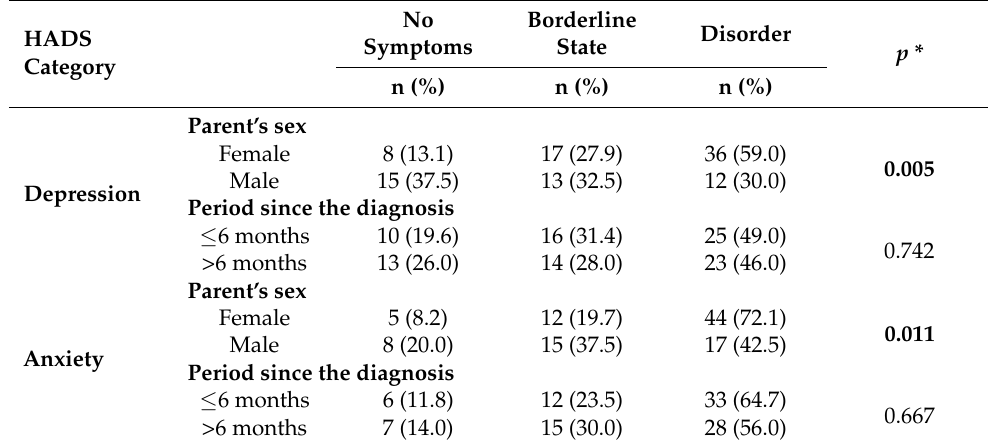
Table 3. Parental depression and anxiety according to parents’ sex and period of time since child’s diagnosis by